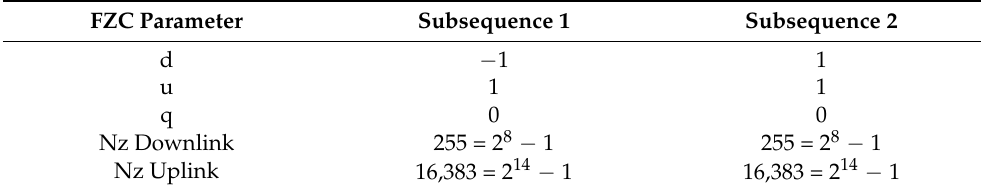
Table 3. Downlink Beacon Sync Fields.